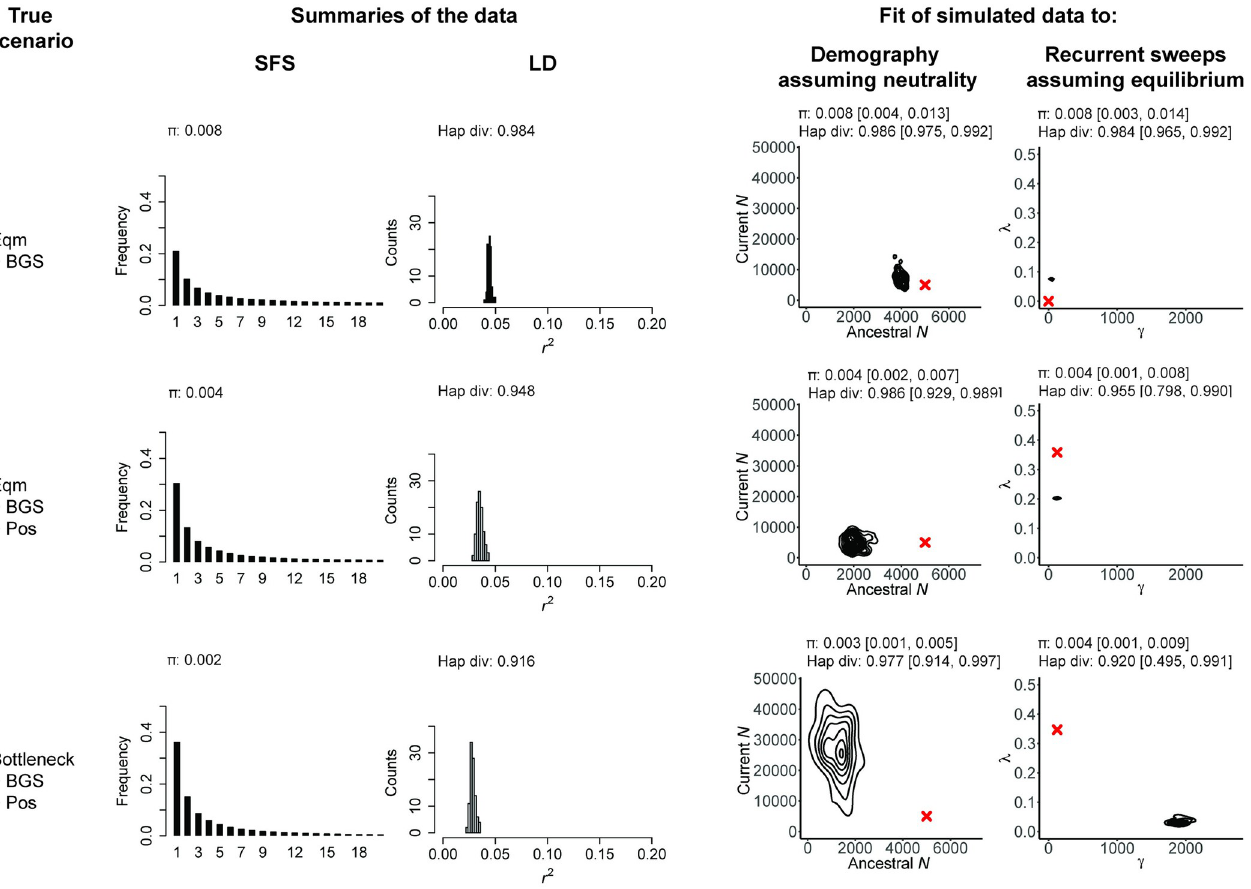
Fig 1. Incorrect models may often readily be fit to a given dataset. Here, we present 3 scenarios varying from simple to more complex: The first row presents a constant-sized population experiencing background selection (denoted by “Eqm + BGS”), the second row is the same scenario with the addition of recurrent selective sweeps (denoted by “Eqm +BGS + Pos”), and the final row adds a population bottleneck (denoted by “Bottleneck + BGS + Pos”). For each scenario, the resulting SFS (truncated to n = 20) and LD ( r 2 ) distributions are given, together with mean pairwise ( π ) and haplotype diversity. To these simulated data, we fit 2 incorrect models: one assuming all sites are neutral but including a change in population size and a second model in which there are recurrent selective sweeps, no change in population size, and all mutations are assumed to be neutral or beneficial (with a population-scaled beneficial selection coefficient ( γ ) and the fraction of beneficial substitutions ( λ ) being estimated from the data). For each inference panel, the red cross gives the true value, the distribution presents the joint posterior obtained from the ABC analysis, and the summary statistics given above the posteriors represent the mean values, and the range from the 95% CIs, obtained from posterior checks. In all cases, exonic sites (i.e., directly selected sites) were masked, and the summary statistic calculations as well as inference is based only on neutral regions (see Methodology). As shown, demographic and selection models can be fit to all datasets, often resulting in strong mis-inference when the assumptions underlying the estimation procedure are violated. The scripts underlying this figure may be found at https://github.com/ paruljohri/Perspective_Statistical_Inference/tree/main/SimulationsTestSet/Figure1. L AU : AbbreviationlistshavebeencompiledforthoseusedthroughoutFigs 1 (cid:0) 3 ; 5 ; and 6 : Pleaseverifythatallentriesarecorrect : D, linkage disequilibrium; SFS, site frequency